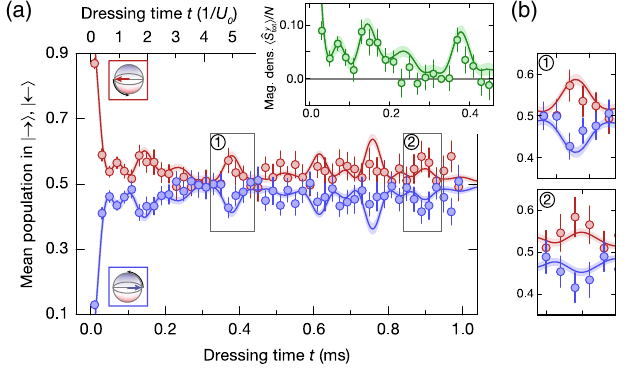
FIG. 2. Evolution of the mean magnetization density. (a) The probability to measure atoms in the states j ← i ( j → i ) vs total dressing time t shown as red (blue) data points. The final spin rotation before detection is indicated by the pictograms (upper and lower left corner). The upper axis is scaled in units of the inverse nearest-neighbor interaction 1 = j U 0 j ¼ 76 ð 3 Þ μ s. The total atom number was restricted to be N < 15 to filter out events with clear preparation errors. The solid line shows the theoretically expected dynamics, averaged over 100 initial chains randomly selected from a reference data set with an initial filling of 87(3)% and a mean atom number of 10(1.4). The shaded region marks the correspond- ing standard error of the mean (s.e.m.). All data points are an average over at least 50 experimental realizations (150 for t < 0 . 1 ms). The inset shows the initial dynamics of the mean ˆ S y i =N up to t ≈ 6 =U transverse magnetization density h 0 , ob- tot tained from the spin populations (green data points) with the theoretical prediction (green solid line). (b) Zoom-in on two magnetization features at t ≈ 5 =U 0 (1) and t ≈ 12 =U 0 (2), as indicated by the gray boxes in (a). Even at long times up to 12 =U 0 , the nonvanishing magnetization indicates the presence of finite coherence. All error bars on the data points denote one